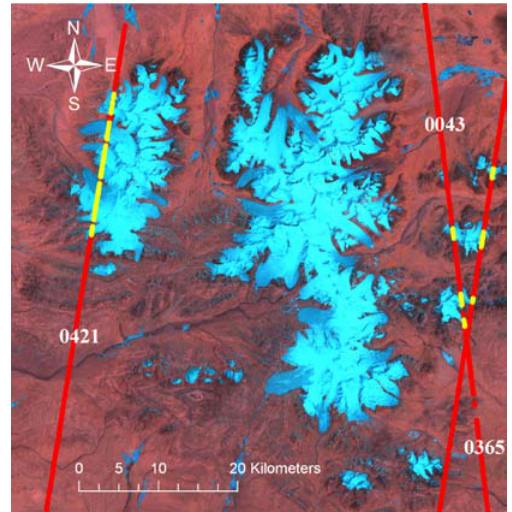
Figure. 2 False-color representation of the Lansat 5 TM image in 2007 with band 5-4-3 as R-G-B channels. Glaciers are shown in light blue. Ground tracks of the ICESAT GLAS data are overlaid. Laser spots on non-glacial areas are shown in red colour, and on glacier in